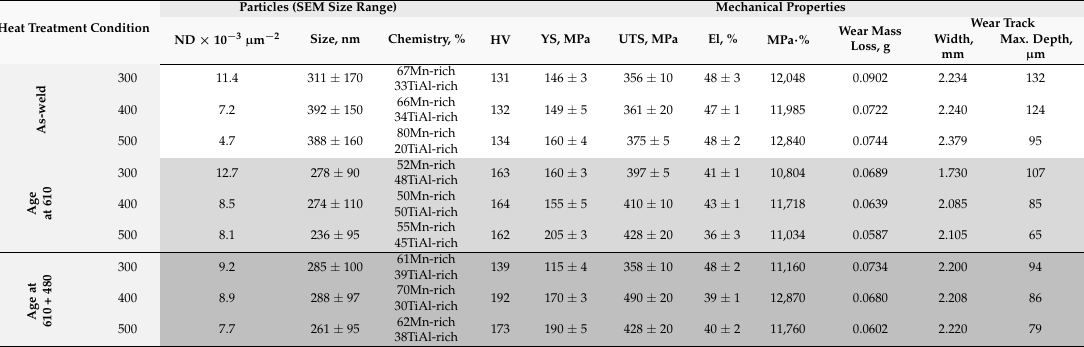
Table 3. The microstructural parameters and mechanical properties variation with heat treatment in